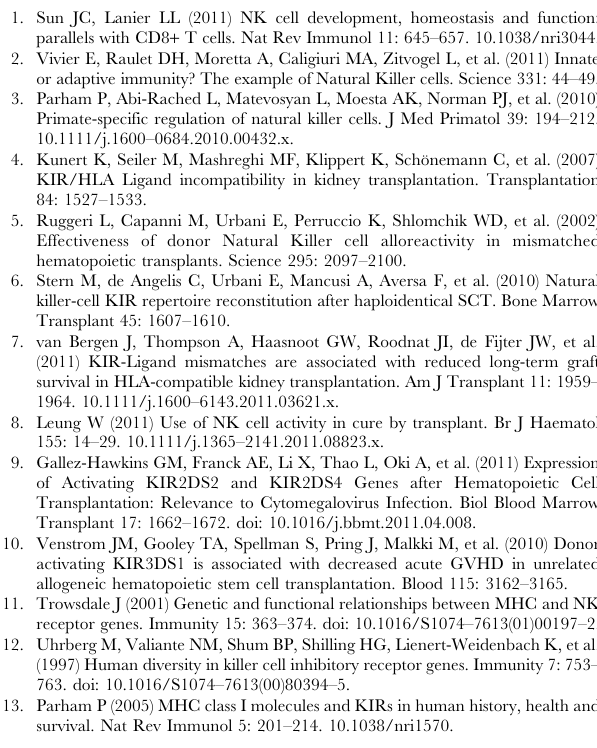
Table S3 KIR MLPA technique probe distribution over